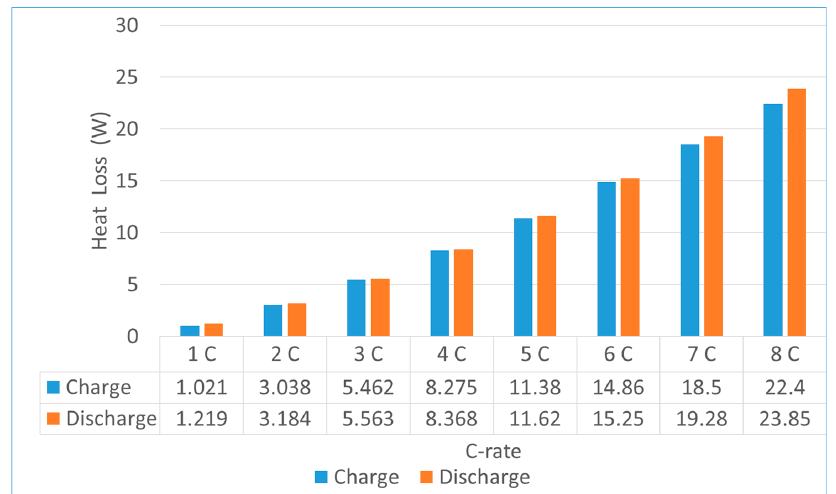
Figure 1. The battery cell heat loss.